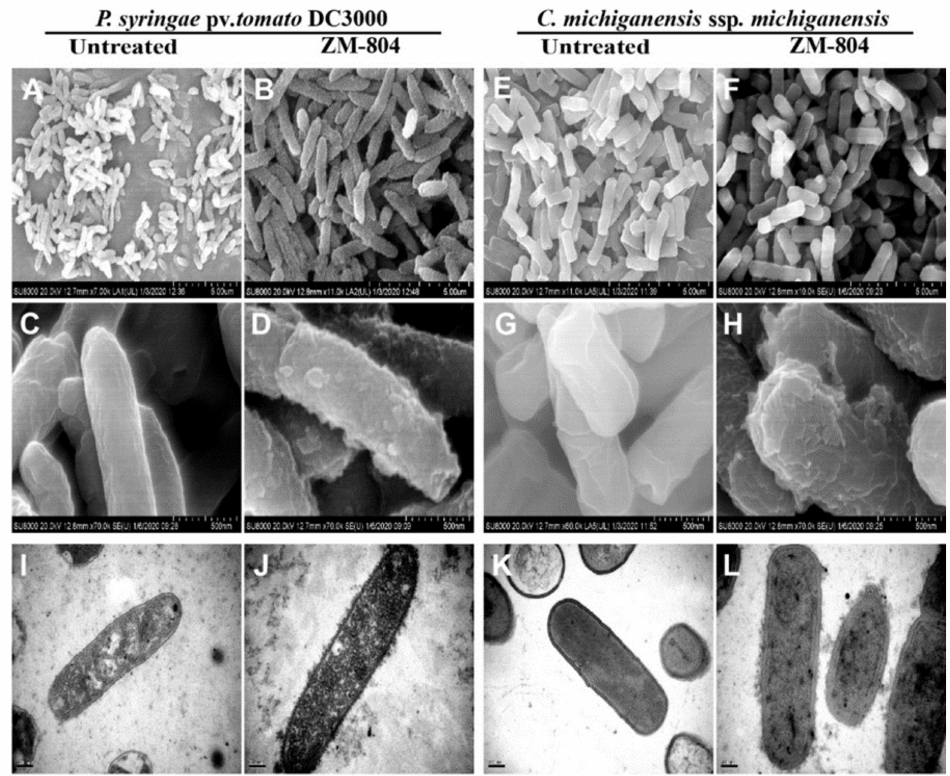
Figure 4. SEM and TEM investigations of P . syringae pv. tomato DC3000 and C . michiganensis subsp. michiganensis after treatment with ZM-804 peptide. Bacterial cells ( ∼ 10 7 CFU/mL) were treated with 4 µ M ZM-804 peptide for 4 h, while the control was treated with dd water. In control bacteria, SEM, and TEM images show that the cell membranes were intact without any cell damage ( A , C , E , G , I , K ). ( B , D , F , H ): The cell membrane of bacteria treated with ZM-804 was covered with bubbles and became rough. ( J , L ): This showed that the cell membrane was disrupted and substances remained present in the intercellular fluid. The results were obtained by the HITACHI SU810 for SEM and the HITACHI H-7650 for